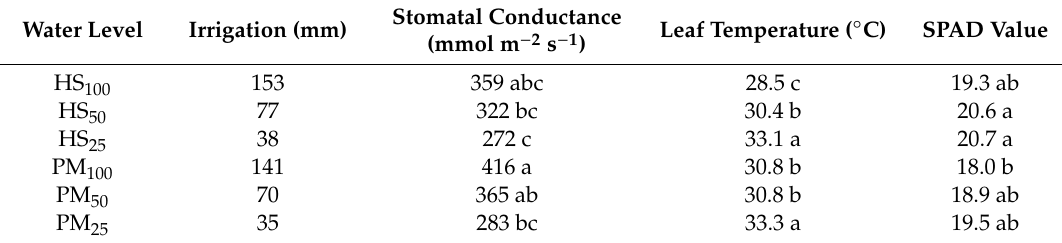
Table 9. Experiment 3: E ff ect of irrigation strategy on the physiological parameters of lettuce. Di ff erent letters indicate significant di ff erences in the Tukey HSD test ( p ≤ 0.05). Data are the means of four replicates. HS 75 = recovery of 75% ET c calculated by the Hargraves–Samani equation; HS 100 =